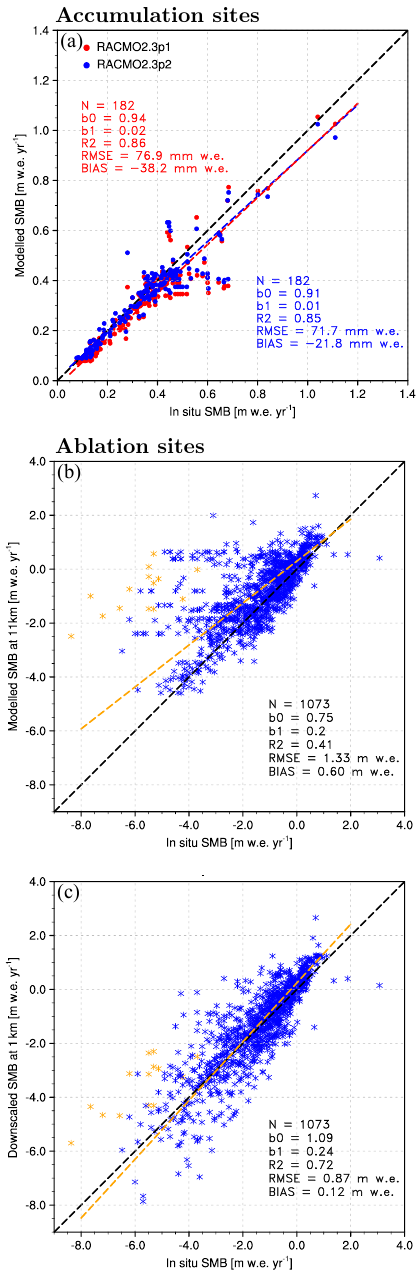
Figure 11. Comparison between (a) modelled, i.e. RACMO2.3p2 (blue) and RACMO2.3p1 (red) at 11km, and observed SMB (mw.e.yr − 1 ) collected in the GrIS accumulation zone (white dots in Fig. 1). Regressions for RACMO2.3p2 (blue) and version 2.3p1 (red) are displayed as dashed lines. Comparison between SMB mea- surements from the GrIS ablation zone (yellow dots in Fig. 1) and (b) original RACMO2.3p2 data at 11km, (c) downscaled product at 1km. Orange stars correspond to measurements collected at sta- tion QAS_L at the southern tip of Greenland. Regression including all records is displayed as orange dashed line in panels (b) and (c) . Main statistics including number of records ( N ), regression slope (b0) and intercept (b1), determination coefficient ( R 2 ), bias and RMSE are listed for each